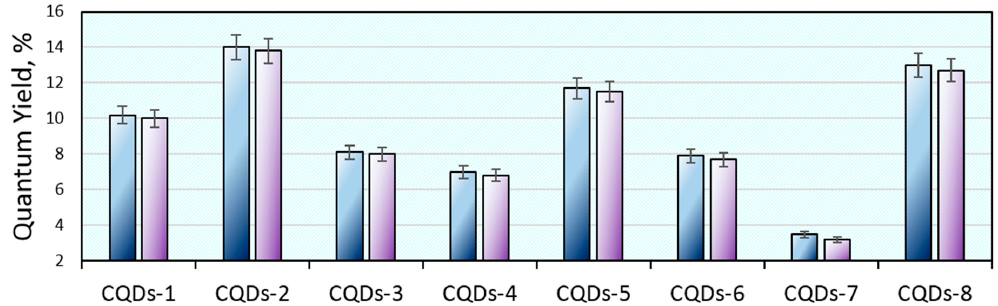
Figure 7. Prepared CQDs irradiated with the diode (365 nm).